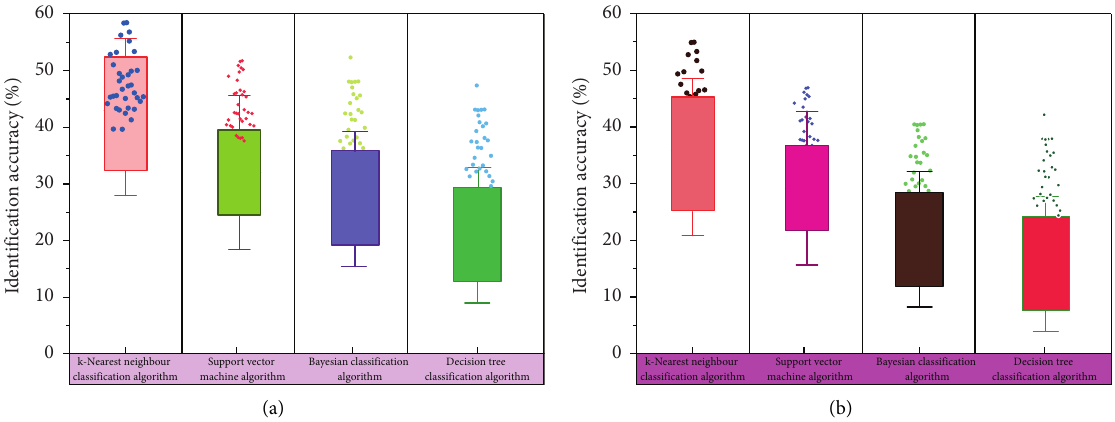
Figure 8: Relationship between recognition degree of different algorithms and NSR: (a) NSR � 0.3 and (b) NSR �